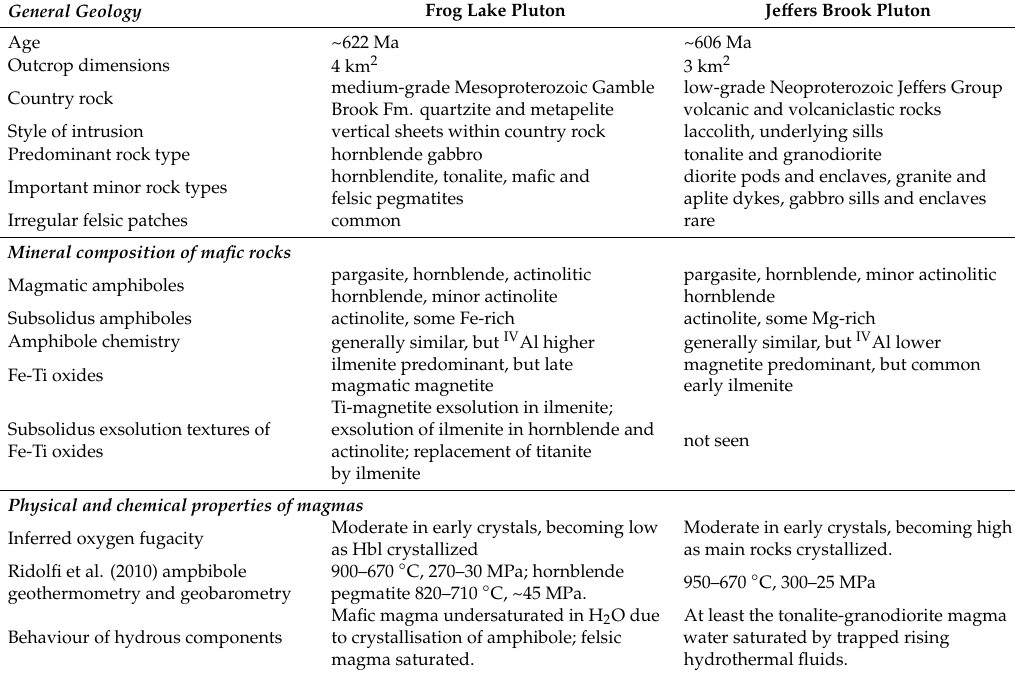
Table 5. Summary of the di ff erences between the Frog Lake and Je ff ers Brook plutons. General